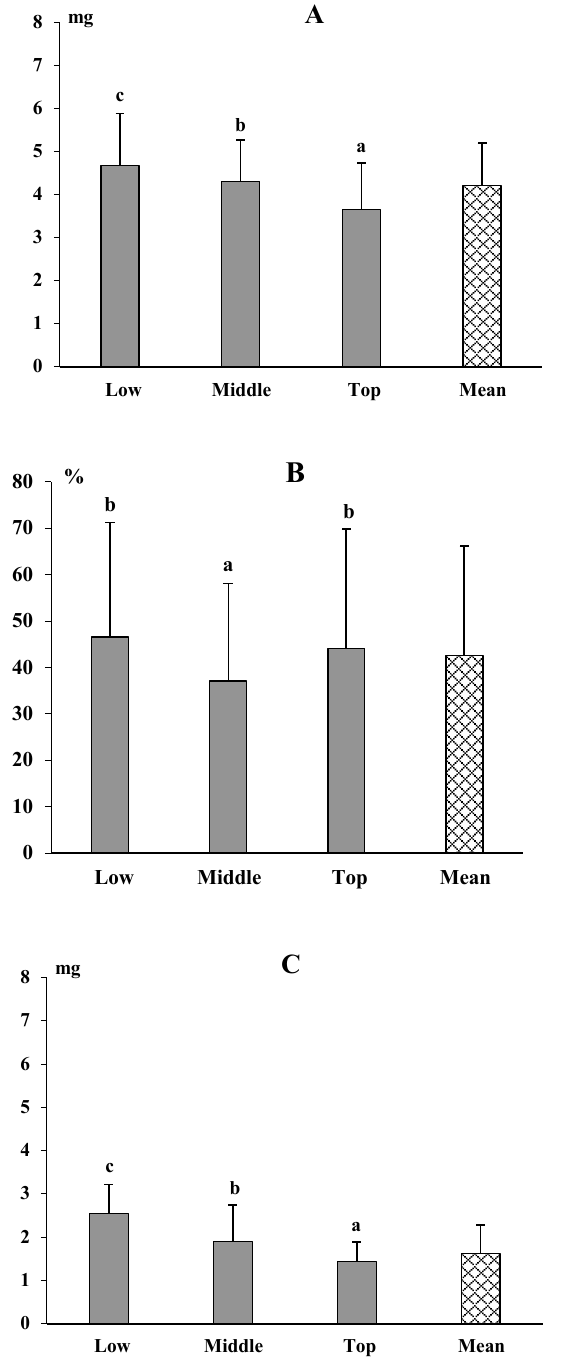
Fig. 3 The amount of secreted nectar ( A ), the sugar concen- tration ( B ), and the mass of sugars per flower ( C ) depending on the position of the flower in inflorescence of Hyacinthus orientalis ‘Sky Jacket’ (means from